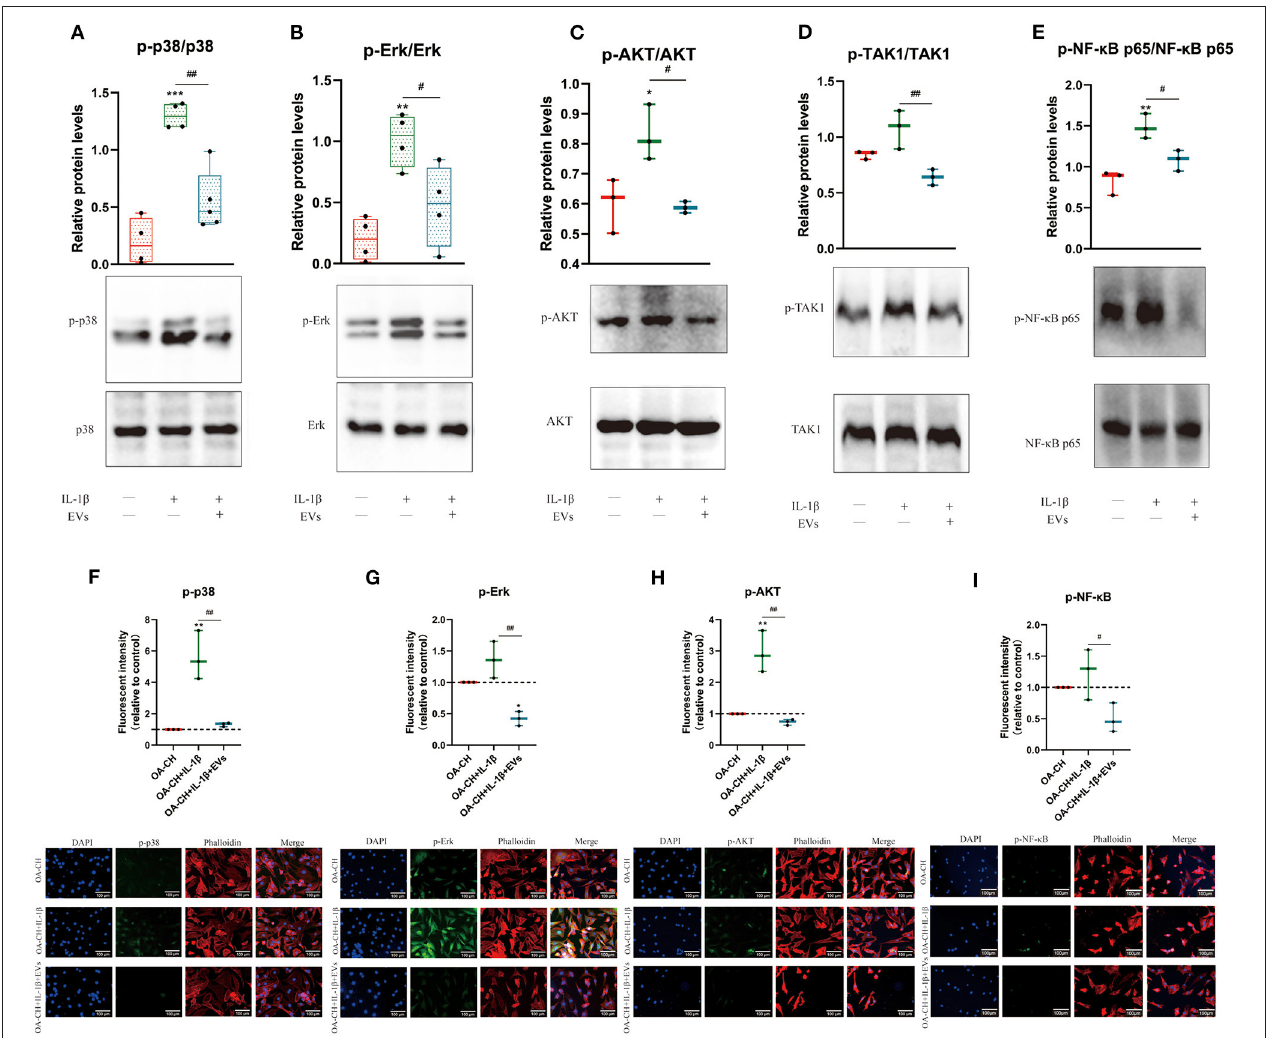
FIGURE 7 | hBMSC-EV effects on IL-1 β -induced activation of Erk1/2, PI3K/Akt p38, TAK1, and NF- κ B signaling pathways in OA-CH. The phosphorylation levels of Erk1/2, PI3K/Akt, p38, TAK1, and NF- κ B in OA-CH were detected by western blotting and immunofluorescence staining. (A–E) Quantification of protein phosphorylation level (upper panel) and representative western blot images (lower panel) of Erk1/2, P13K/Akt, p38, TAK1, and NF- κ B after 30min of stimulation with Il-1 β and EVs. (F–I) Immunofluorescence staining (lower panel) and quantification of protein expression of the phosphorylated forms of Erk1/2, P13K/Akt, p38, and NF- κ B (upper panel) in OA-CH after treatment with hBMSC-EVs and/or IL-1 β . Scale bar = 100 µ m. All values represent mean ± standard deviation. *Significant differences to OA-CH group (control group): * p < 0.05; ** p < 0.01; *** p < 0.001; # significant differences between groups: # p < 0.05; ## p < 0.01; one-way ANOVA with Newman–Keuls Multiple Comparison Test; n =